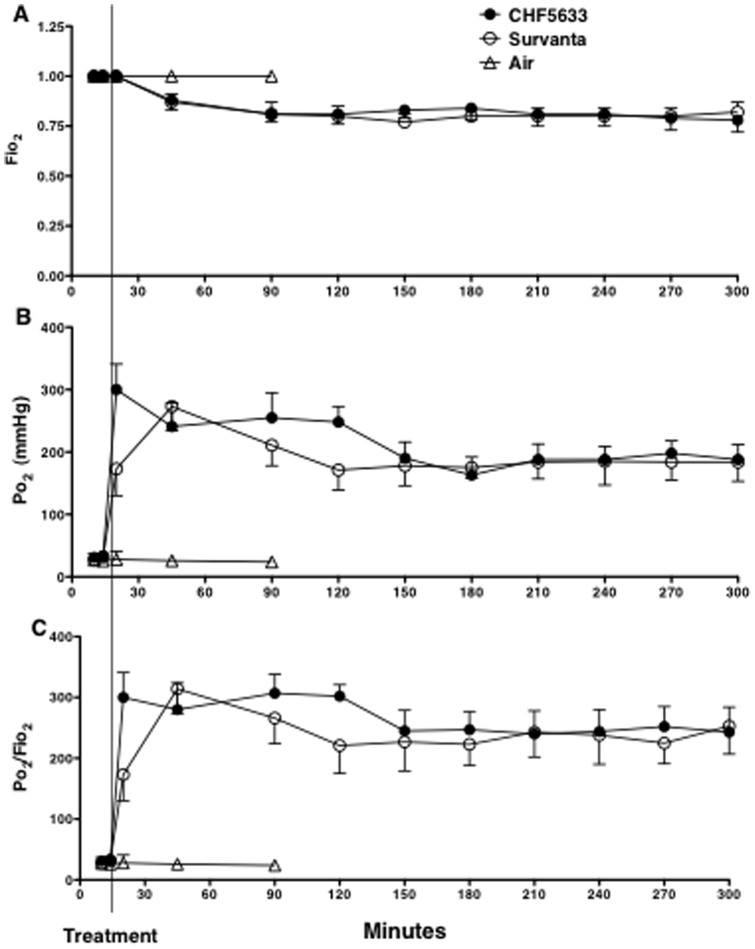
Oxygenation.These preterm newborn lambs required high Fio2 (A) to maintain Po2 (B) at targeted level. Ratio of Po2 to Fio2 (C) was improved soon after surfactant treatment. Although not significant, the increase in Po2/Fio2 after treatment tends to be faster by CHF5633 than Survanta (p = 0.052 at 20 min).